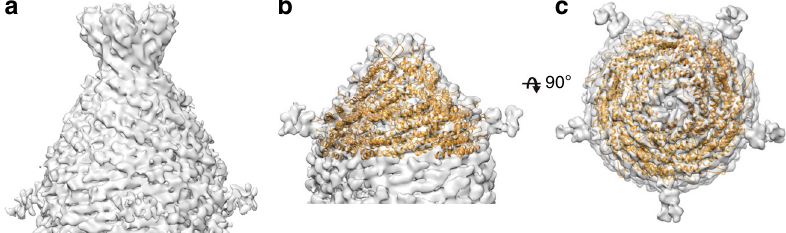
Fig. 4 Reconstruction of the APBV1 cap structures. a EM map of “ pointy ” tip and end fi bers possibly involved in recognition of the host receptor proteins. b , c EM map of “ blunt ” tip is shown from the side ( b ) and the top ( c ). The tip was modeled by fi tting VP1 structure as a rigid body. The cap structure has fi ve-fold symmetry. The tilt of the subunits changes with each level on approach to the tip of the cap. The additional densities on the sides of the cap were putatively assigned to a glycan attached to the VP1 subunit residue